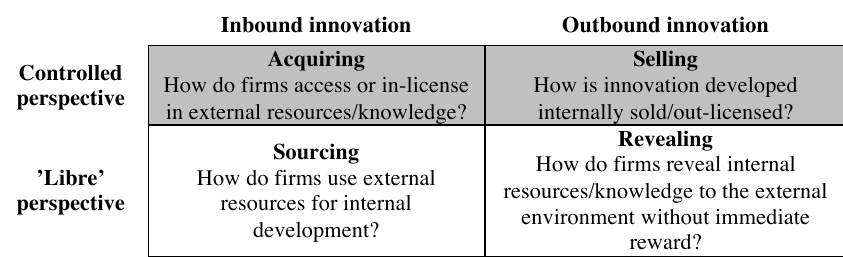
Table 2: The OI practices and sub-practices (adapted from Dahlander & Gann,